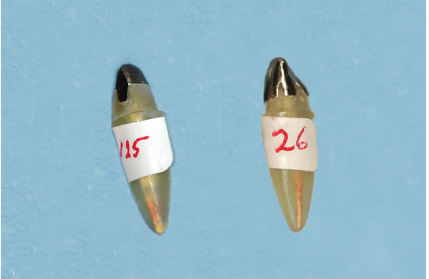
Figure 5: Specimen of cemented cast post in each group.